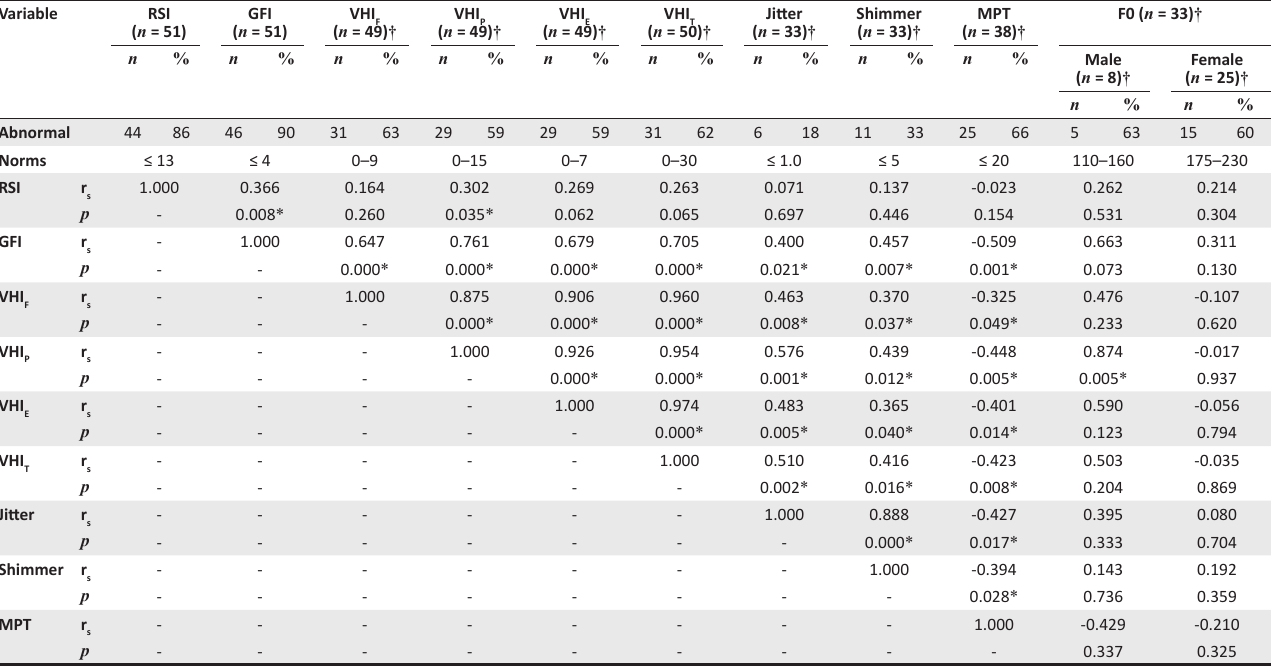
TABLE 3: Abnormal outcomes and Spearman correlations between self-rating and acoustic